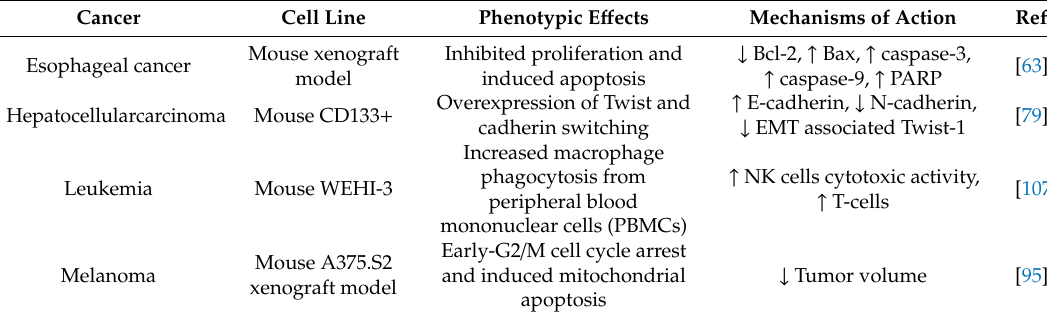
Table 2. Antineoplastic e ff ects of casticin under in vivo